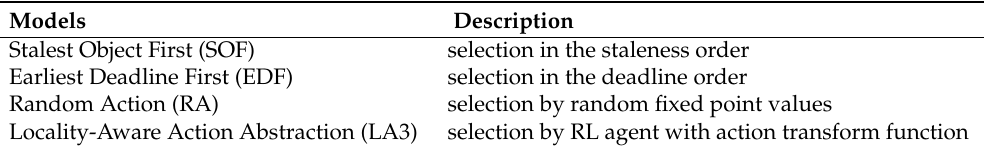
Table 1. Models in comparison.